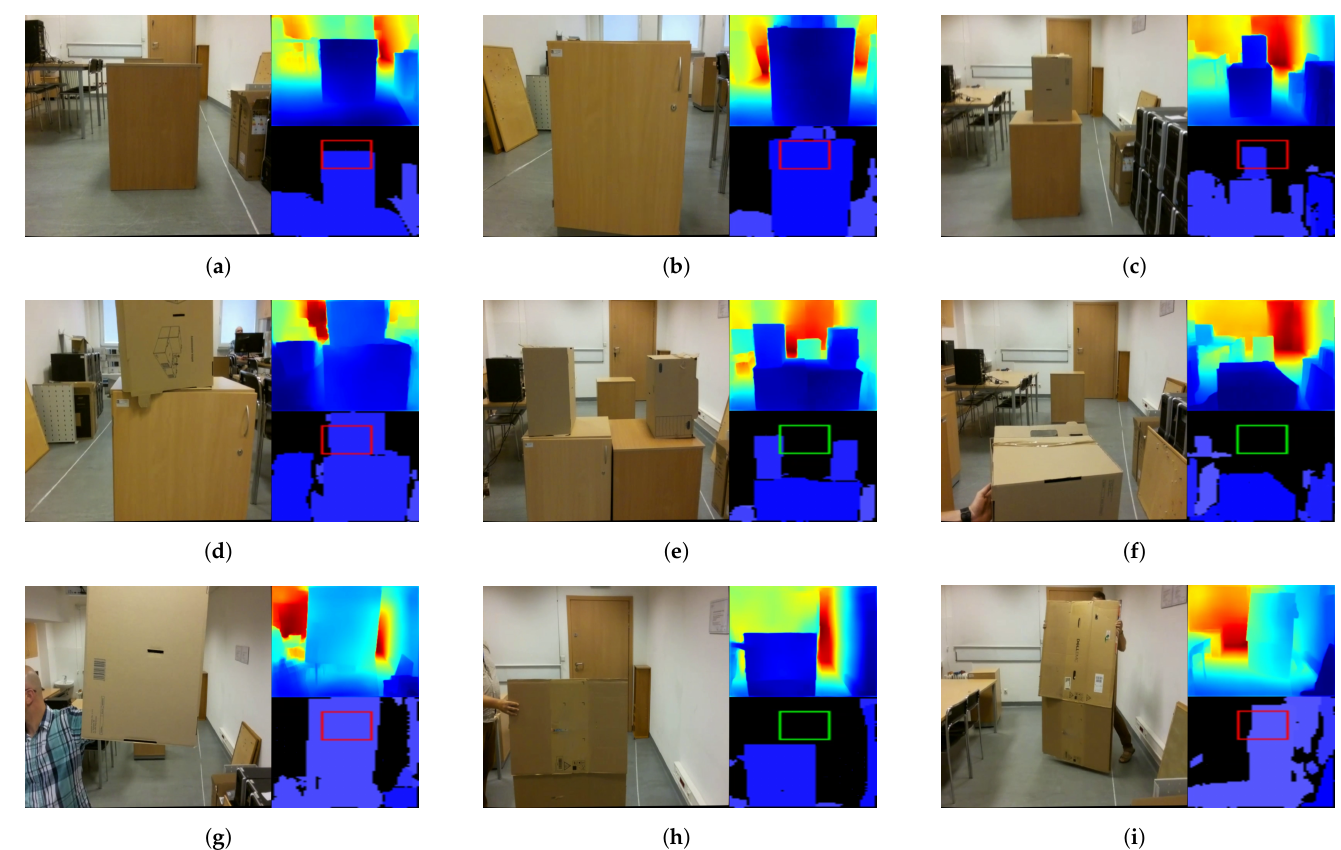
Figure 5. Different types of obstacles used during Algorithm 1 testing. In each sub-image, on the left is an RGB image, at the top right is a depth map estimated by proposed E-D, and at the bottom right are potential obstacles in the drone’s path as detected by Algorithm 1. If the rectangle is red, the algorithm predicts that the drone may collide with the obstacle. If the rectangle is green, the algorithm decides that there are no obstacles in the path. ( a ) Static obstacle 60 × 50 × 75 cm. ( b ) Static obstacle 60 × 40 × 80 cm. ( c ) Static obstacle with height 120 cm. ( d ) A second static obstacle with height 120 cm. ( e ) Static obstacle with a 45 cm deep “valley”. ( f ) Dynamic obstacle that is not on the drone’s flight trajectory. ( g ) A dynamic obstacle on a drone’s flight trajectory. ( h ) Dynamic